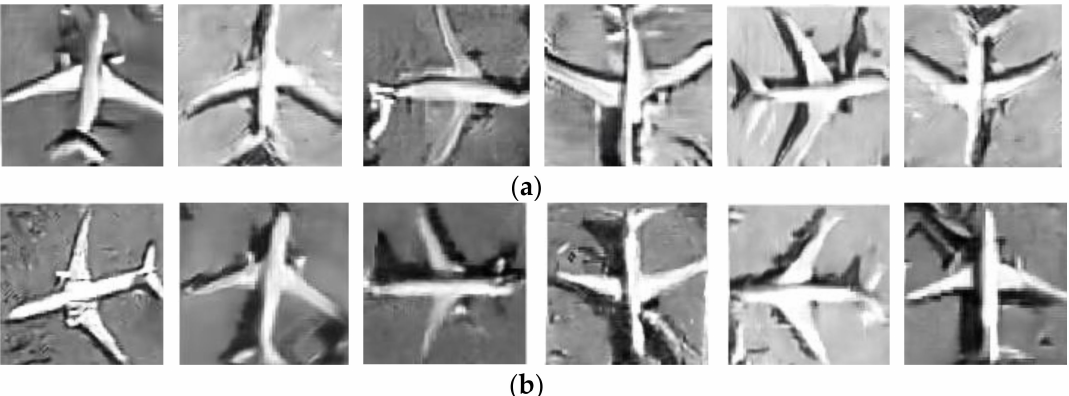
Figure 8. Generated pictures of modified shuffle attention GAN with and with equal stretch resize method. ( a ) Generated pictures with original resize method; ( b ) generated pictures with the equal stretch resize